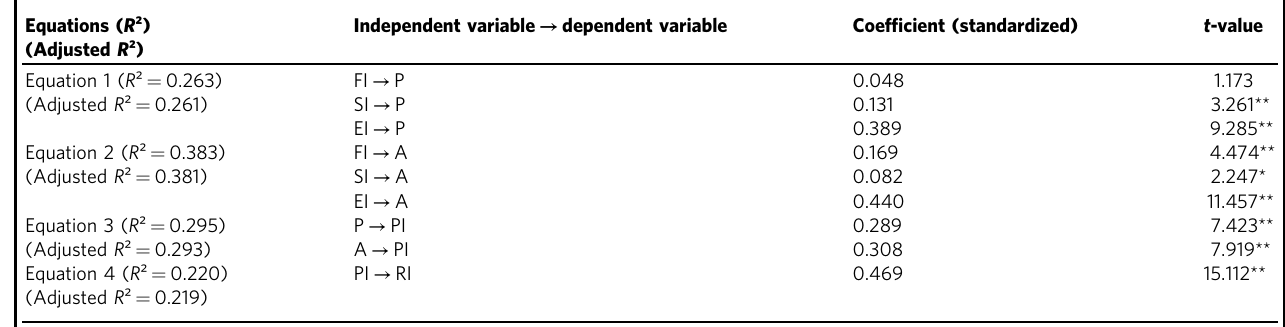
Table 4 Results of the regression